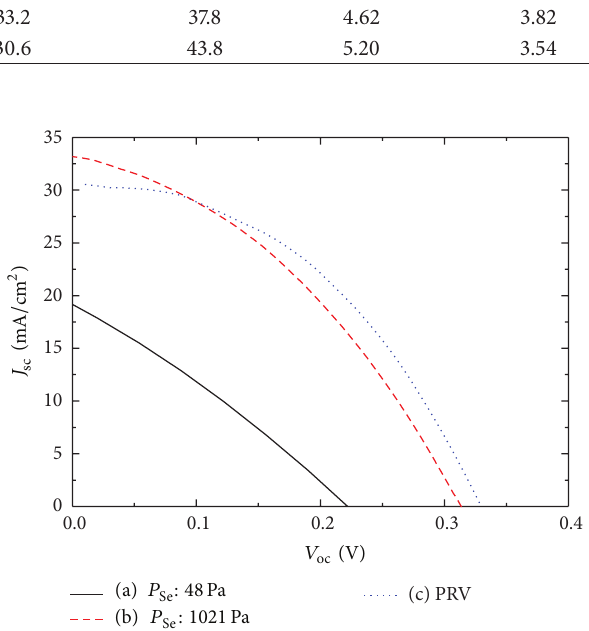
Figure 5: Photovoltaic performance of CIGS solar cells with various selenization pressures: (a) 48 Pa, (b) 1.02 × 10 3 Pa, and (c)